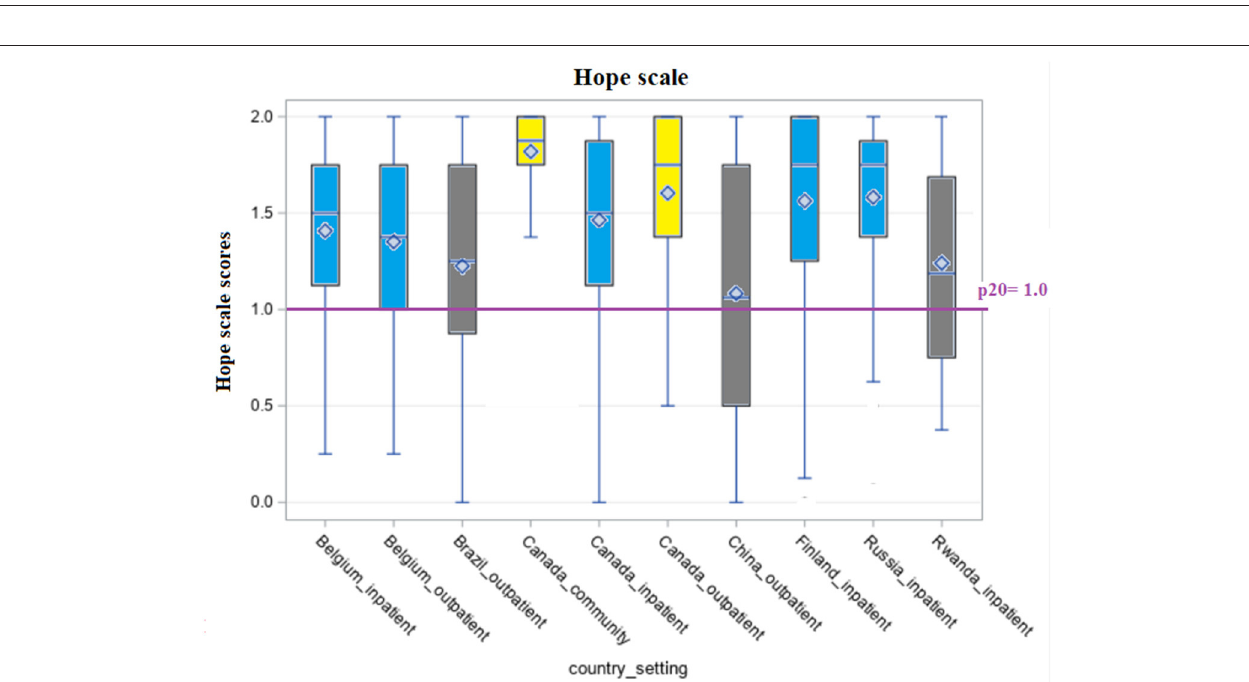
FIGURE 3 | Distribution of scores of the scale “Hope” across countries and settings.